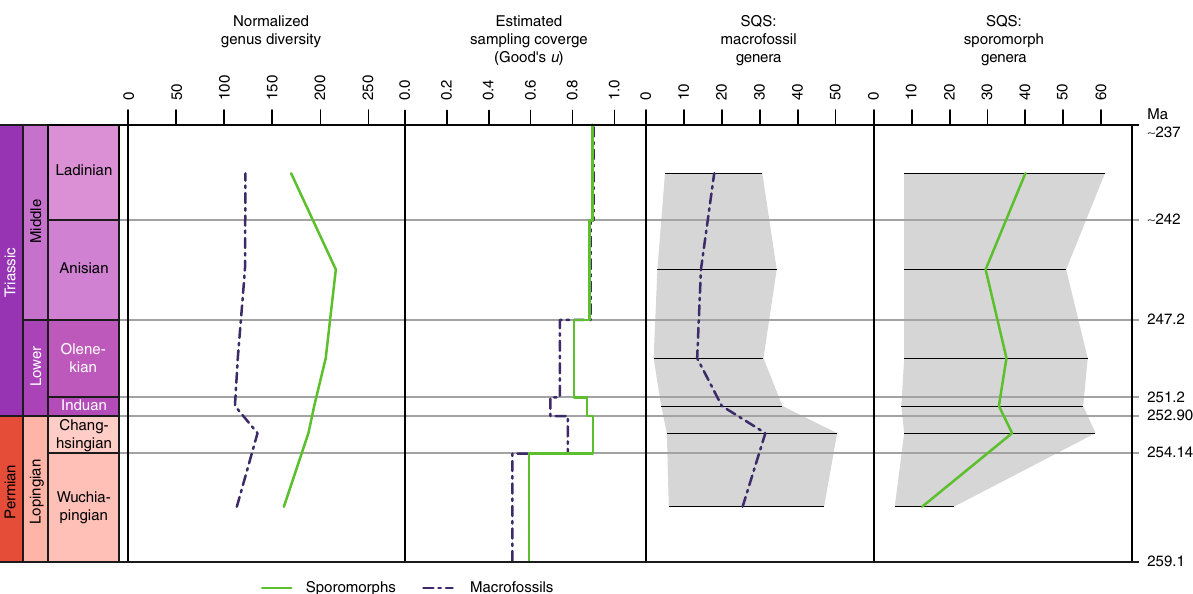
Fig. 2 Origination, extinction, turnover and single-stage genera. Counts and rates per million years stage duration for plant macro- and microfossils. P. = Permian, Lop. = Lopingian